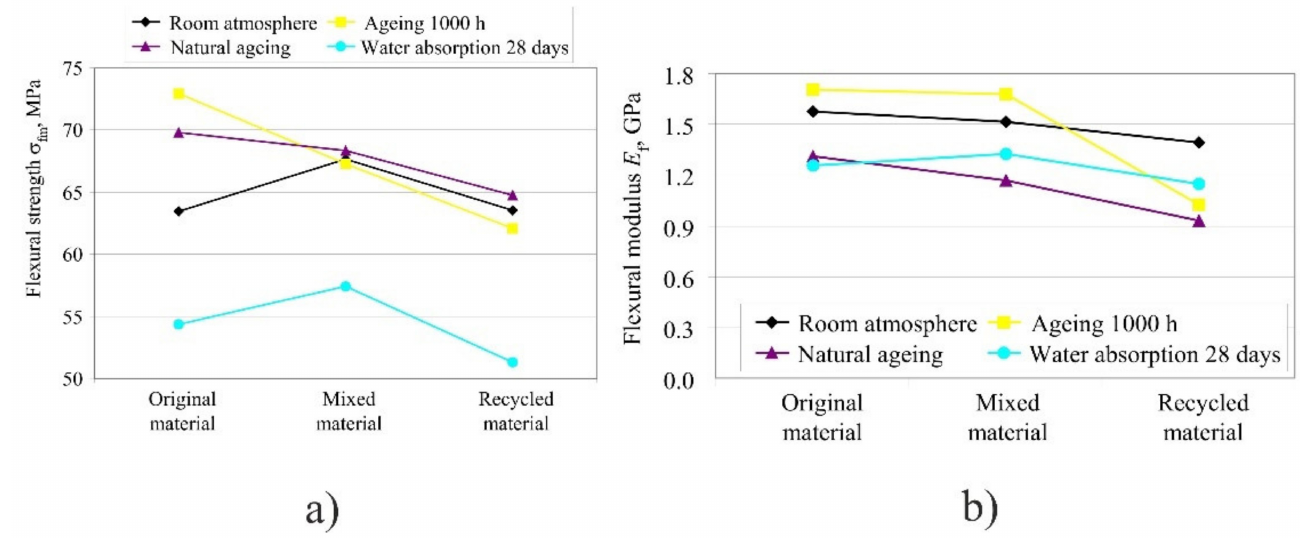
Figure 19. Impact of atmospheric conditions on flexural strength and modulus in different types of materials: ( a ) diagram for flexural strength, ( b ) diagram for flexural